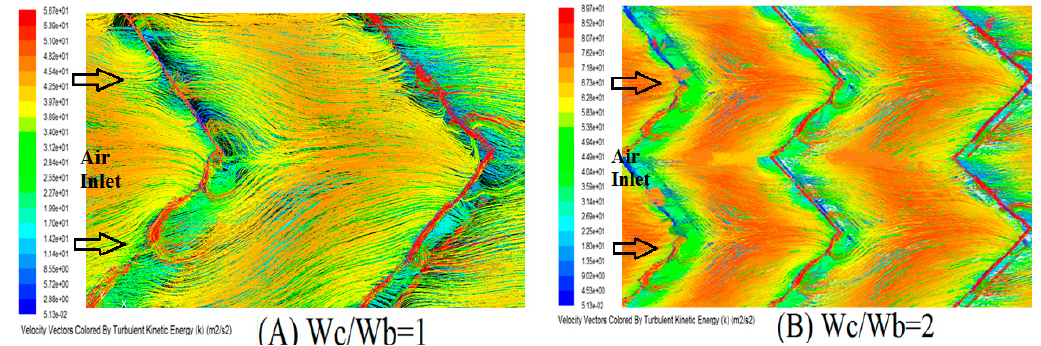
Figure 7. Contour plot of turbulent kinetic energy for: ( A ) Wc / Wb = 1; and ( B ) Wc / Wb = 2 ( e/H = 0.6, P/e = 8.0, O/e = 0.42, β = 12%, α = 60°, and R e = 5000).